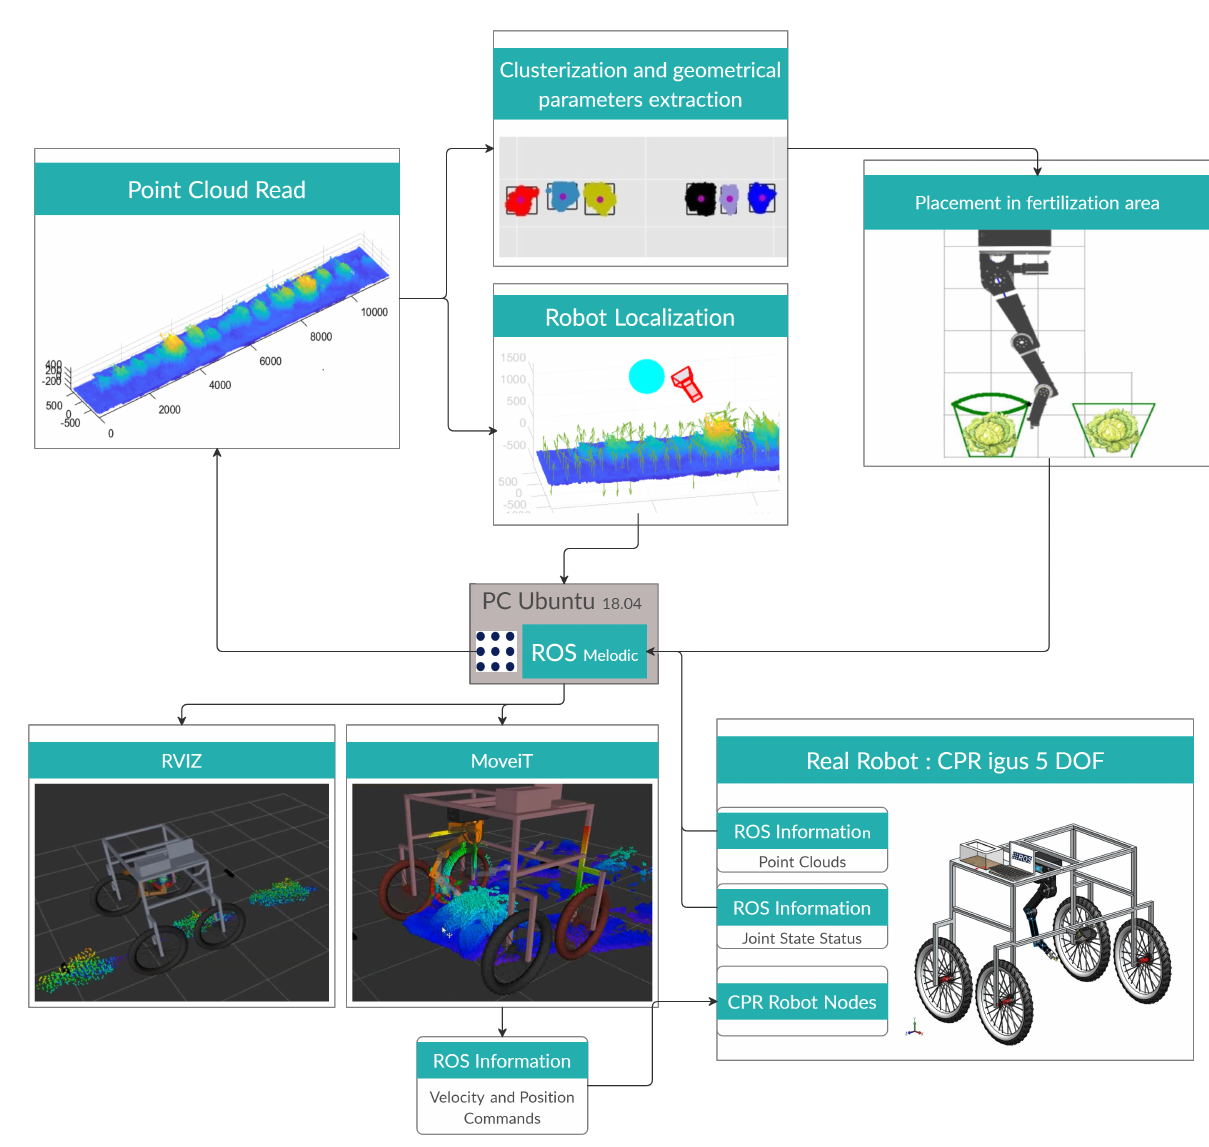
Figure 3. Layout of subsystems connection: data acquisition, clusterisation and geometrical parameters extraction, place- ment in fertilisation area, localisation and motion planning. Source: